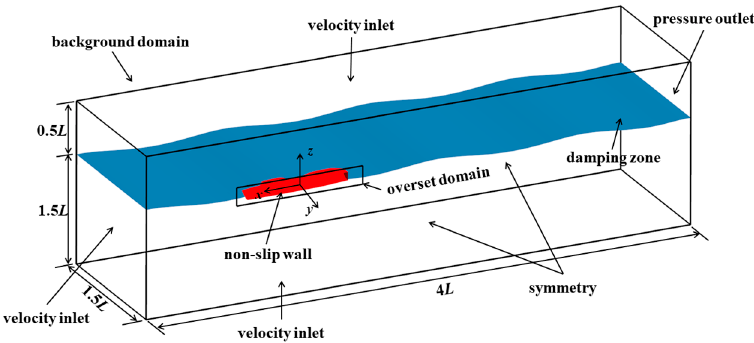
Figure 5. The computational domain and boundary